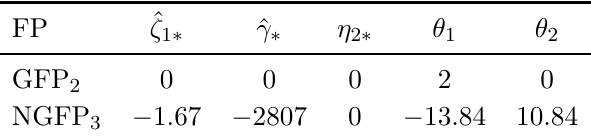
Table 2 . Properties of the finite FPs seen with dimensionless field. The second and third columns give the values of the couplings (2.12); the fourth the anomalous dimension and the last two the scaling